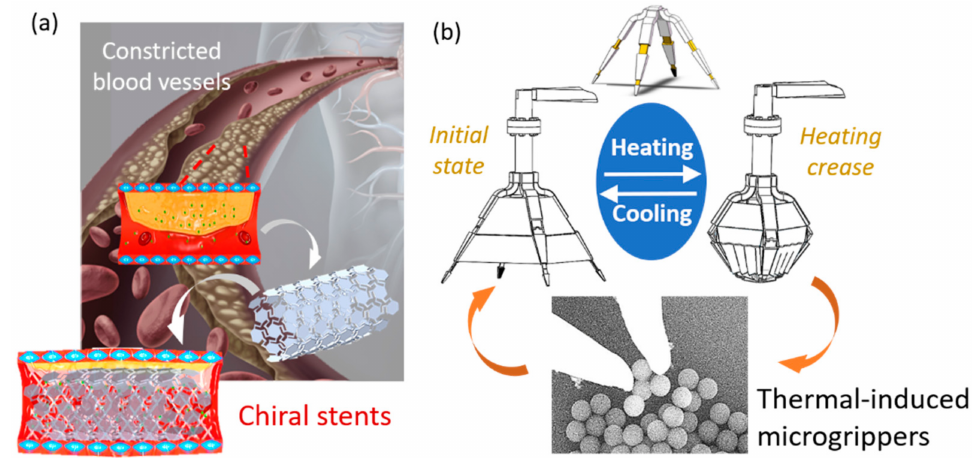
Figure 8. Potential applications of ( a ) chiral stents and ( b ) origami grippers as thermoresponsive